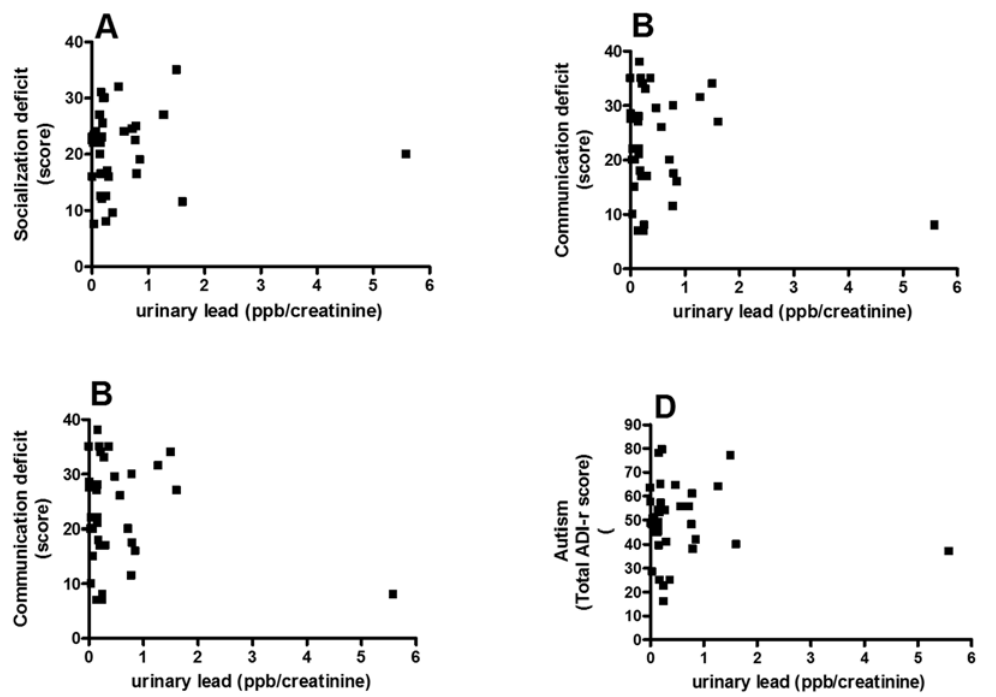
Figure 2. Correlation between the score in the socialization ( A ); communication ( B ); and stereotyped/restricted activities ( C ) and total the revised autism diagnostic interview™ (ADI-R) autism score ( D ) and urinary concentration of